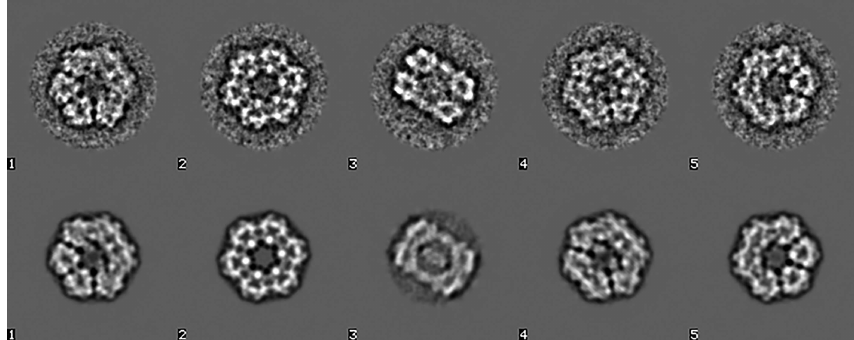
Figure 8 Five class averages used for random startup (top row of Fig. 7) and the corresponding reprojections from the three-dimensional reconstruction. A good correspondence of the class averages to their reprojections is a necessary condition for a valid reconstruction procedure.